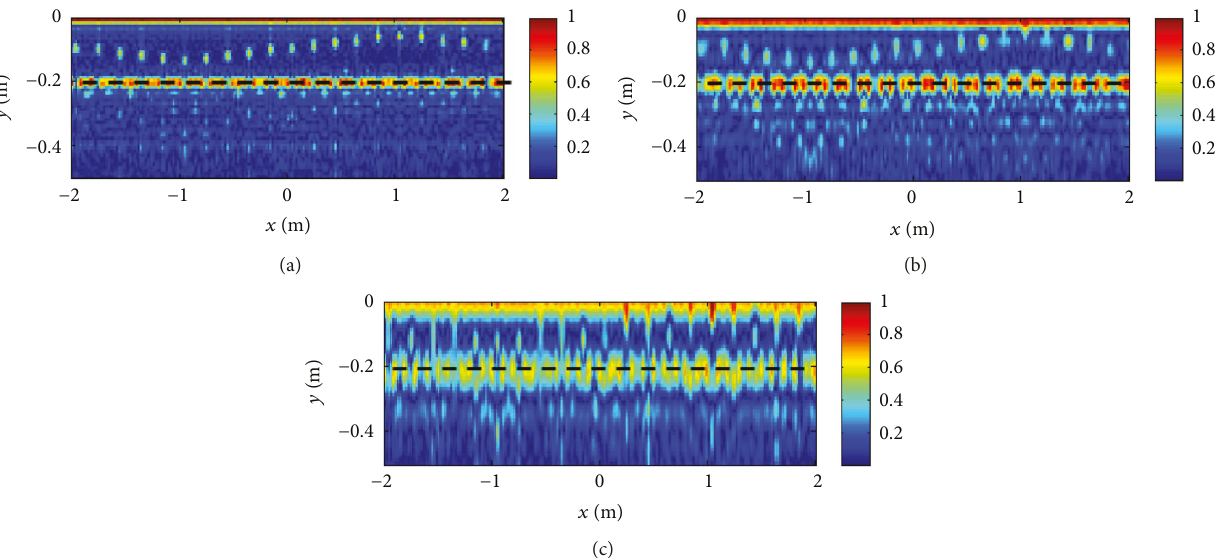
Figure 4: Imaging results with di ff erent signal bandwidths. (a) BW =2.4GHz (Freq=0.8 – 3.2GHz). (b) BW =1.2GHz (Freq=1.4 – 2.6GHz). (c) BW =0.6GHz (Freq=1.7 –